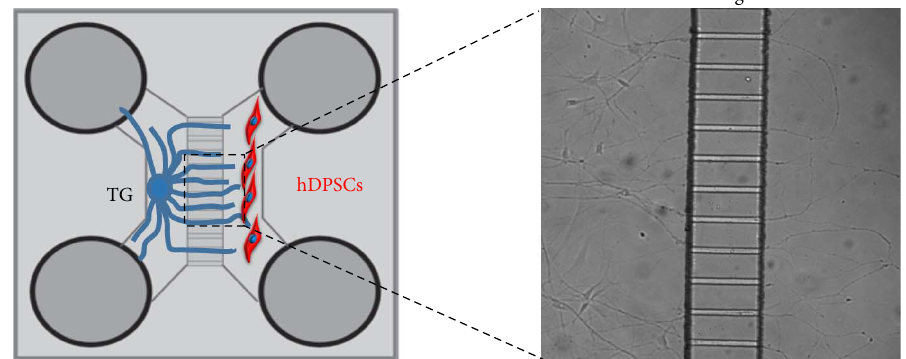
Figure 2: Schematic representation of coculture between trigeminal ganglia (TG) and human dental pulp stem cells (hDPSCs) through microfluidic devices. In this system, both cell types/tissues are cultured in optimal conditions, while allowing the growth of trigeminal ganglia axons through microgrooves (mg) to innervate the stem